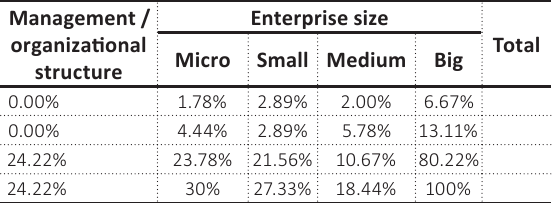
Table 1. Development trend in organizational and management structures based on the size